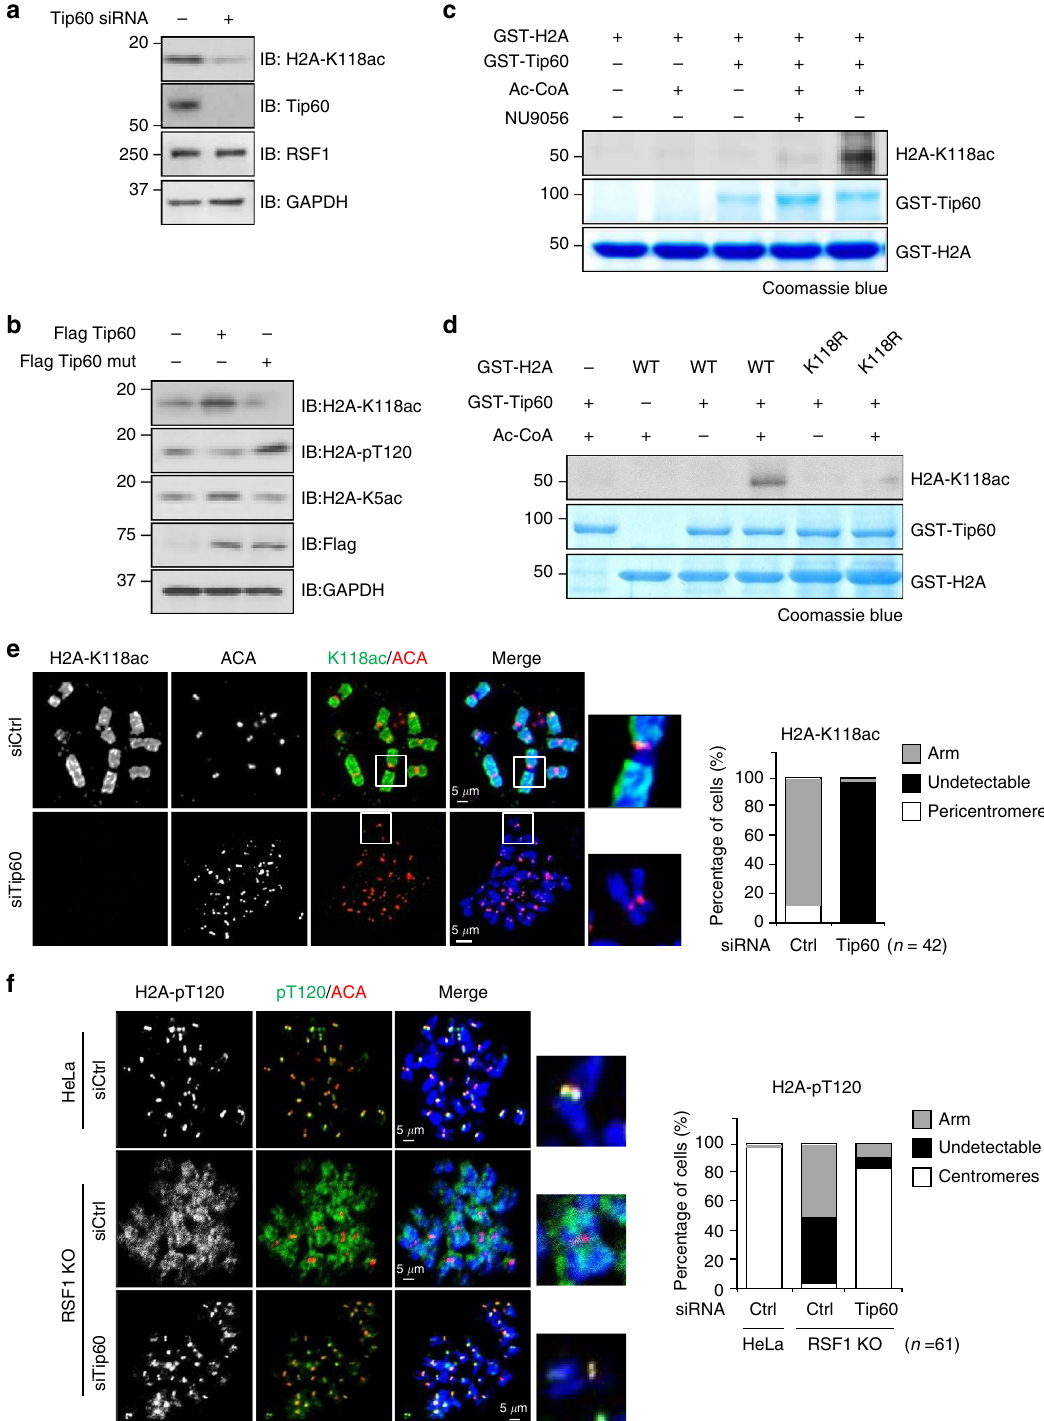
Fig. 6 The acetyltransferase Tip60 mediates H2A-K118 acetylation. a HeLa cells were transfected with siTip60 and arrested in mitosis and mitotic cell lysates were subjected to immunoblotting. b Lysates of HeLa cells transfected with Flag-Tip60 WT or catalytic mutant of Tip60 were blotted with indicated antibodies. c Recombinant GST-H2A protein was incubated with puri fi ed GST-Tip60 in the presence or absence of Ac-CoA and NU9056, Tip60 speci fi c inhibitor, for in vitro acetylation assay. The acetylation levels of H2A were analyzed with an anti-H2A-K118 acetylation antibody. d Recombinant GST-H2A WT or K118 mutants were incubated with puri fi ed GST-Tip60 in the presence of Ac-CoA for in vitro acetylation assay. The acetylation levels of H2A were analyzed with an anti-H2A-K118 acetylation antibody. e Mitotic HeLa cells depleted of Tip60 were stained with anti-ACA (red), anti-H2A-K118ac (green) antibodies. The percentages of cells exhibiting the arm or centromeric level of H2A-K118ac are shown. Scale bar, 5 μ m. f RSF1 WT or knockout HeLa cells were transfected with control or Tip60 siRNA and stained with anti-ACA and anti-H2A-pT120 antibodies. The percentages of cells exhibiting the arm or centromeric level of H2A-pT120 are shown. Scale bar, 5 μ